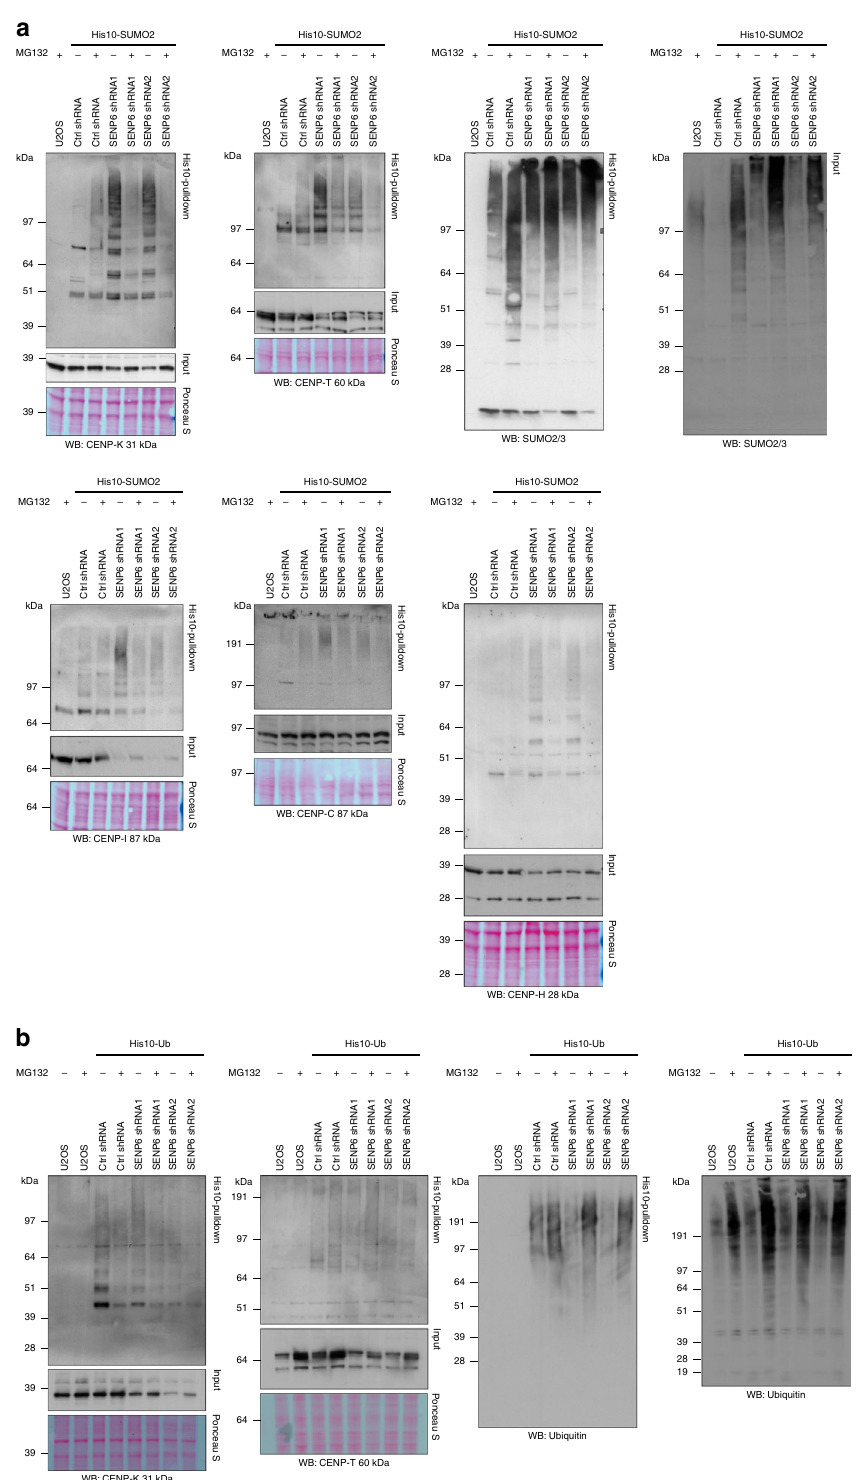
Fig. 5 Poly-SUMOylation does not lead to destabilization of CCAN proteins. a U2OS cells stably expressing His10-SUMO2 were infected with lentiviruses encoding shRNAs against SENP6 or a nontargeting control shRNA (ctrl shRNA) 3 days prior to lysis. Where indicated, cells were treated with 10 µ M MG132 for 4 h prior to lysis. Cells were lysed and SUMOylated proteins were enriched by means of Ni-NTA pulldown. Inputs and His10-pulldown elutions were analysed by immunoblotting with the indicated antibodies. Equal loading was veri fi ed by Ponceau S staining. b U2OS cells stably expressing His10- ubiquitin were infected with lentiviruses encoding shRNAs against SENP6 or a nontargeting control shRNA (ctrl shRNA) 3 days prior to lysis. Where indicated cells were treated with 10 µ M MG132 for 4 h prior to lysis. Cells were lysed and ubiquitinated proteins were enriched by means of Ni-NTA pulldown. Inputs and His10-pulldown elutions were analysed by immunoblotting with the indicated antibodies. Equal loading was veri fi ed by Ponceau S staining. Source data are provided as a Source Data fi